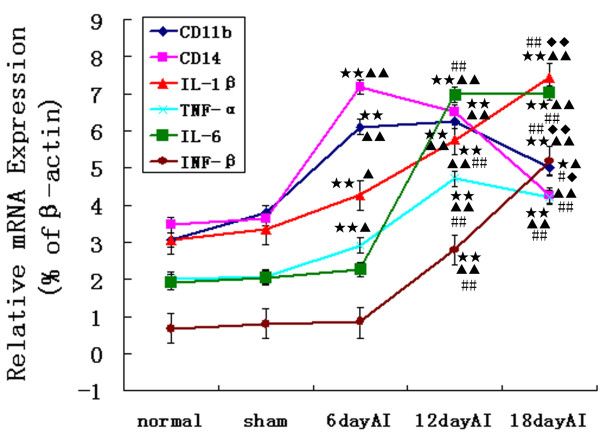
Microglial activation and proinflammatory cytokine expression increases in the bone cancer pain model. Real-time quantitative RT-PCR analyses of the temporal expression of microglial activation markers (CD11b, CD14) and proinflammatory cytokines (IL-6, IL-1β, TNF-α, and INF-β) mRNA in rat lumbar spinal cord. The mRNA expression levels of CD11b and CD14 significantly increased in the bone cancer pain group at six days AI and 12 days AI (n = 4, ANOVA1w, P < 0.01, post hoc Dunnett testing, df = 3, F = 0.98). CD11b mRNA expression was also higher at 18 days AI (P < 0.05). The bone cancer pain group also showed significant up-regulation IL-6, IL-1β, TNF-α, and INF-β mRNA relative to the normal and sham group(n = 4, ANOVA1w, P < 0.01, post hoc Dunnett testing, df = 3, F = 1.11), starting at day six after inoculation for IL-1β and TNF-α (P < 0.05), and at day 12 after inoculation for IL-6 and INF-β (P < 0.01). Values are presented as mean ± SEM. *P < 0.05, **P < 0.01 vs. normal group; ▲ P < 0.05, ▲▲ P < 0.01 vs. sham group; #P < 0.05, ##P < 0.01 vs. 6 days AI; ◆P < 0.05, ◆◆P < 0.01 vs. 12 days AI.